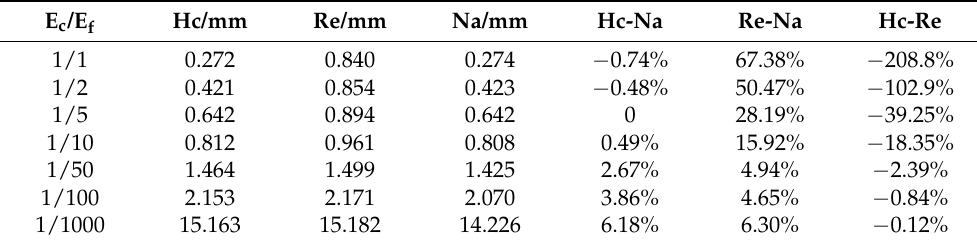
Table 2. Maximum deflection of the circular sandwich plate fixed-end supported at its periphery with different modulus of elasticity of the core layer.